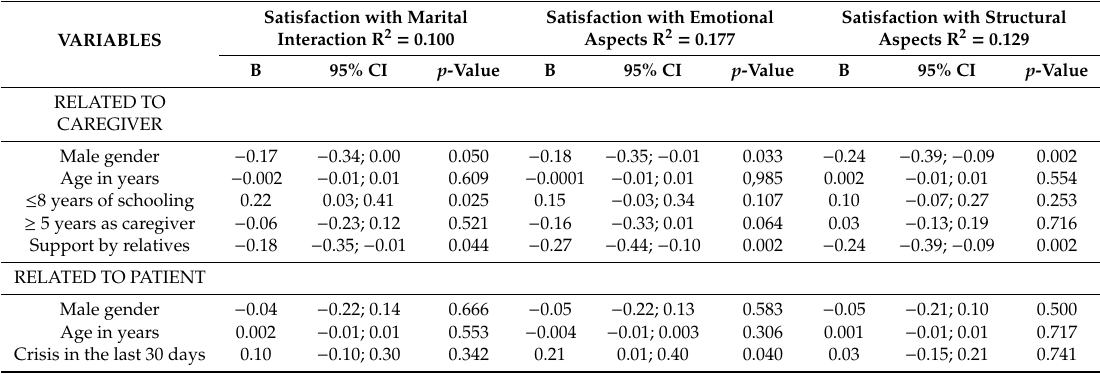
Table 4. Factors associated with MSS a subscales of family caregivers of patients with mental disorders, multiple linear